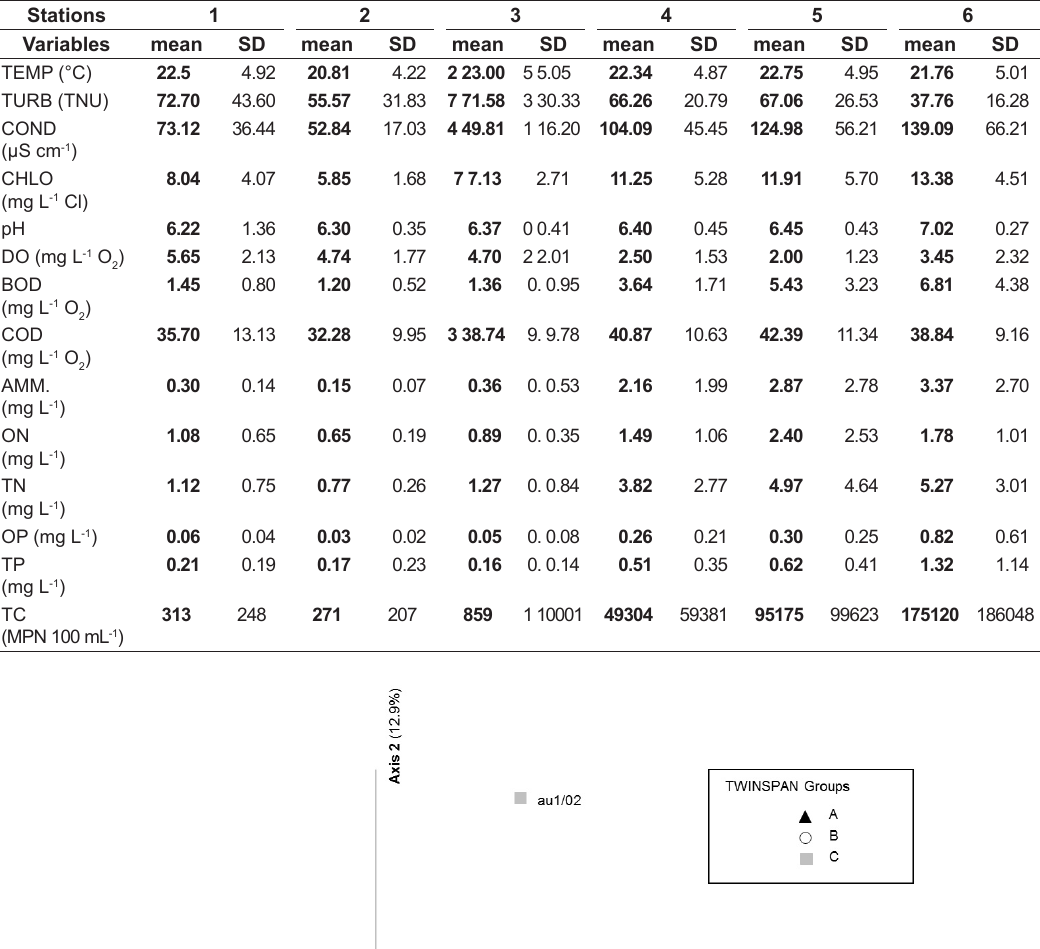
Table 1. Mean ( n =8) and standard deviation (SD), of limnological variables from September 2000 to August 2002, at Chico Lomã stream (station 1) and Gravataí River (stations 2 to 6). Data not measured (---) Data.